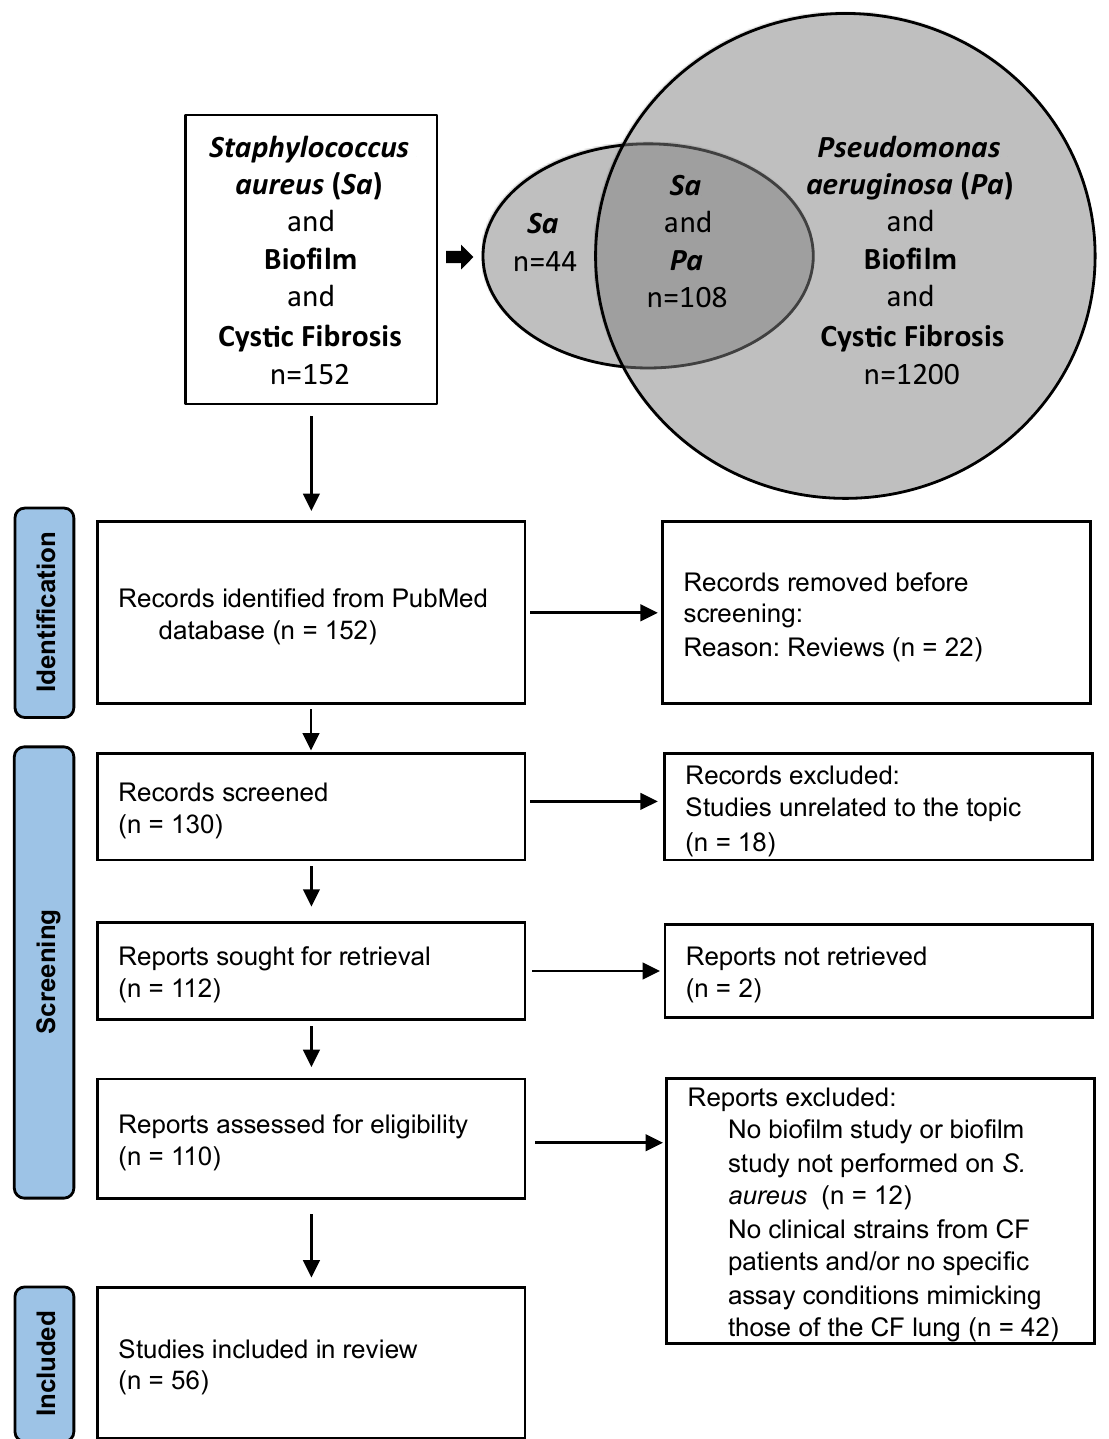
Figure 1. Results of the literature search on S. aureus biofilm in the context of Cystic Fibrosis. (PubMed database, search date: 8 October 2022) ( top ) and flow diagram of study selection ( bottom ). Sa : Staphylococcus aureus ; Pa : Pseudomonas aeruginosa ; n: number of publications (not to scale); CF: Cystic Fibrosis.